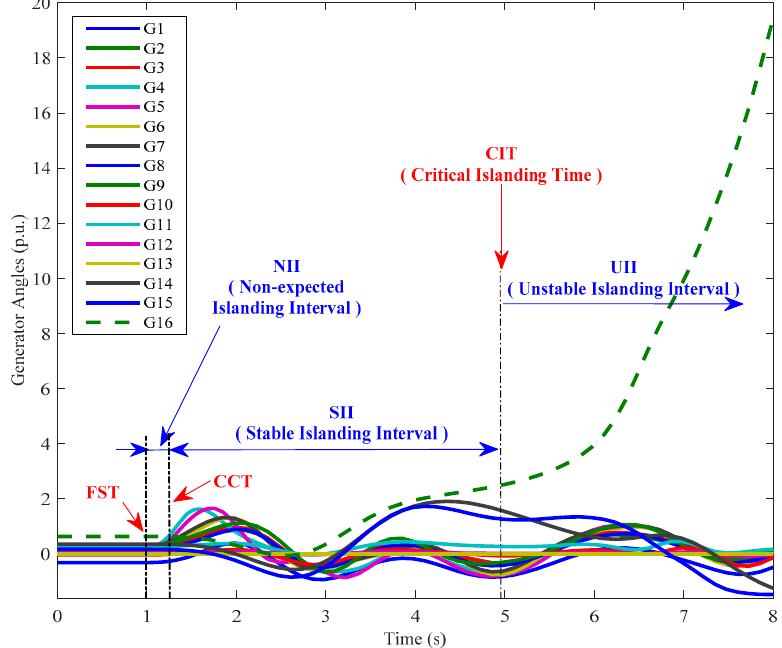
Figure 3. Demonstration on CCT, CIT, NII, SII, and UII for splitting